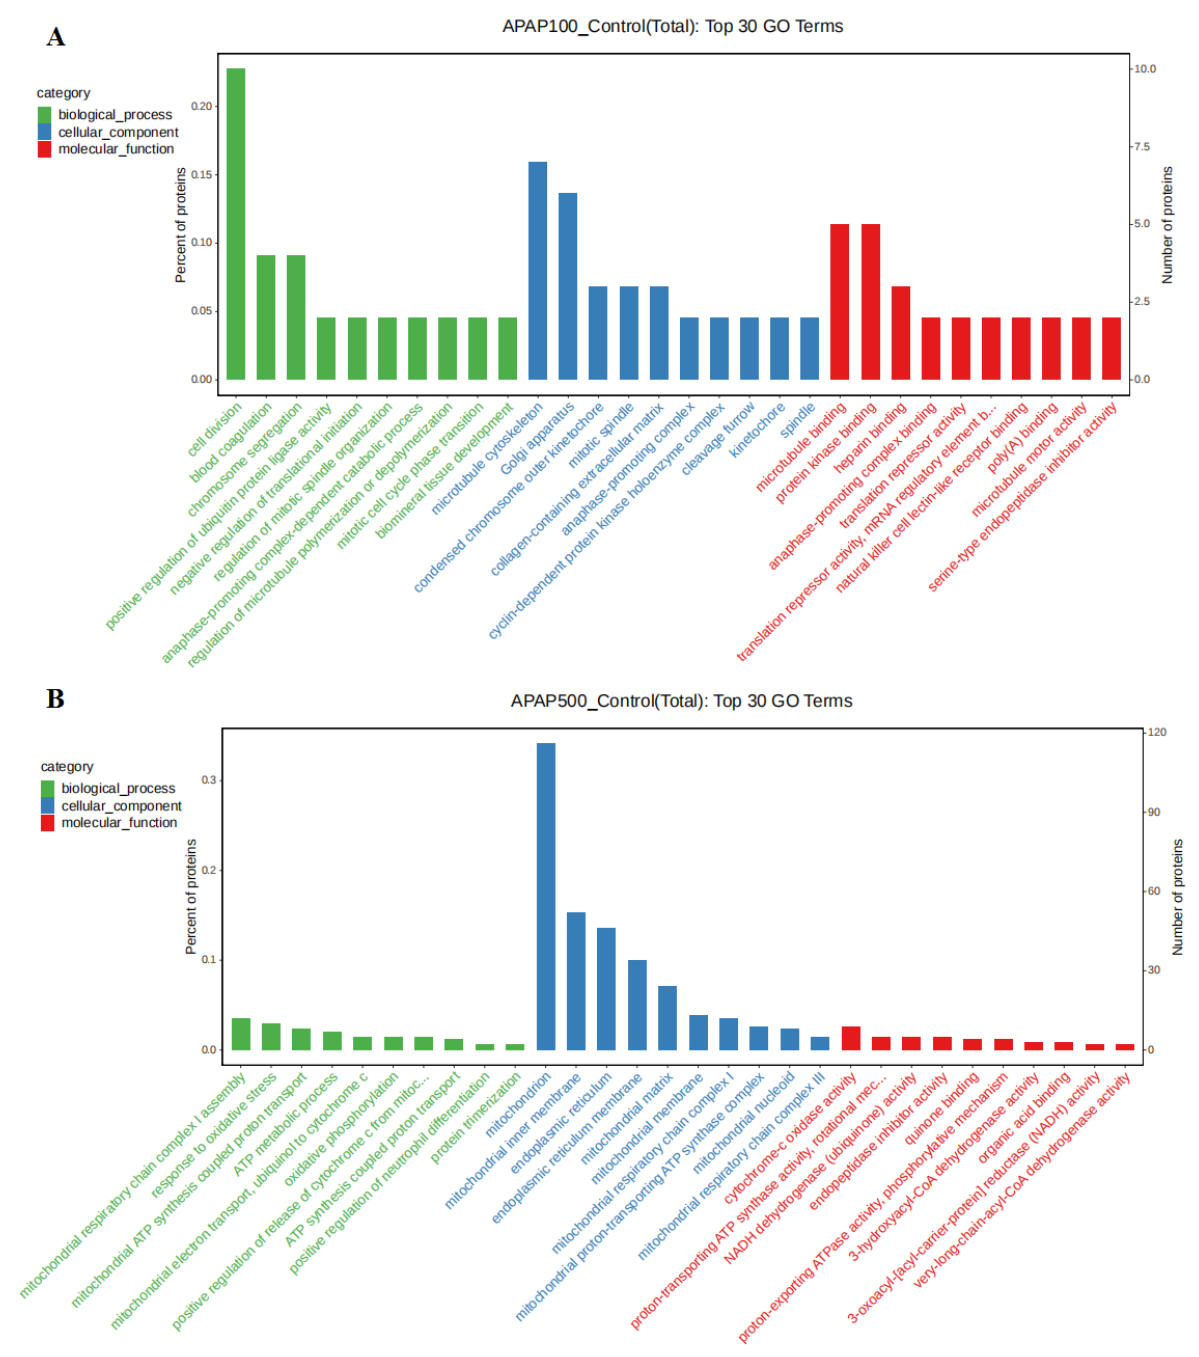
Figure 7. Gene ontology (GO) analysis of differentially expressed proteins of macrophages treated with acetaminophen (APAP). ( A ) APAP100 vs. control group, ( B ) APAP500 vs. control